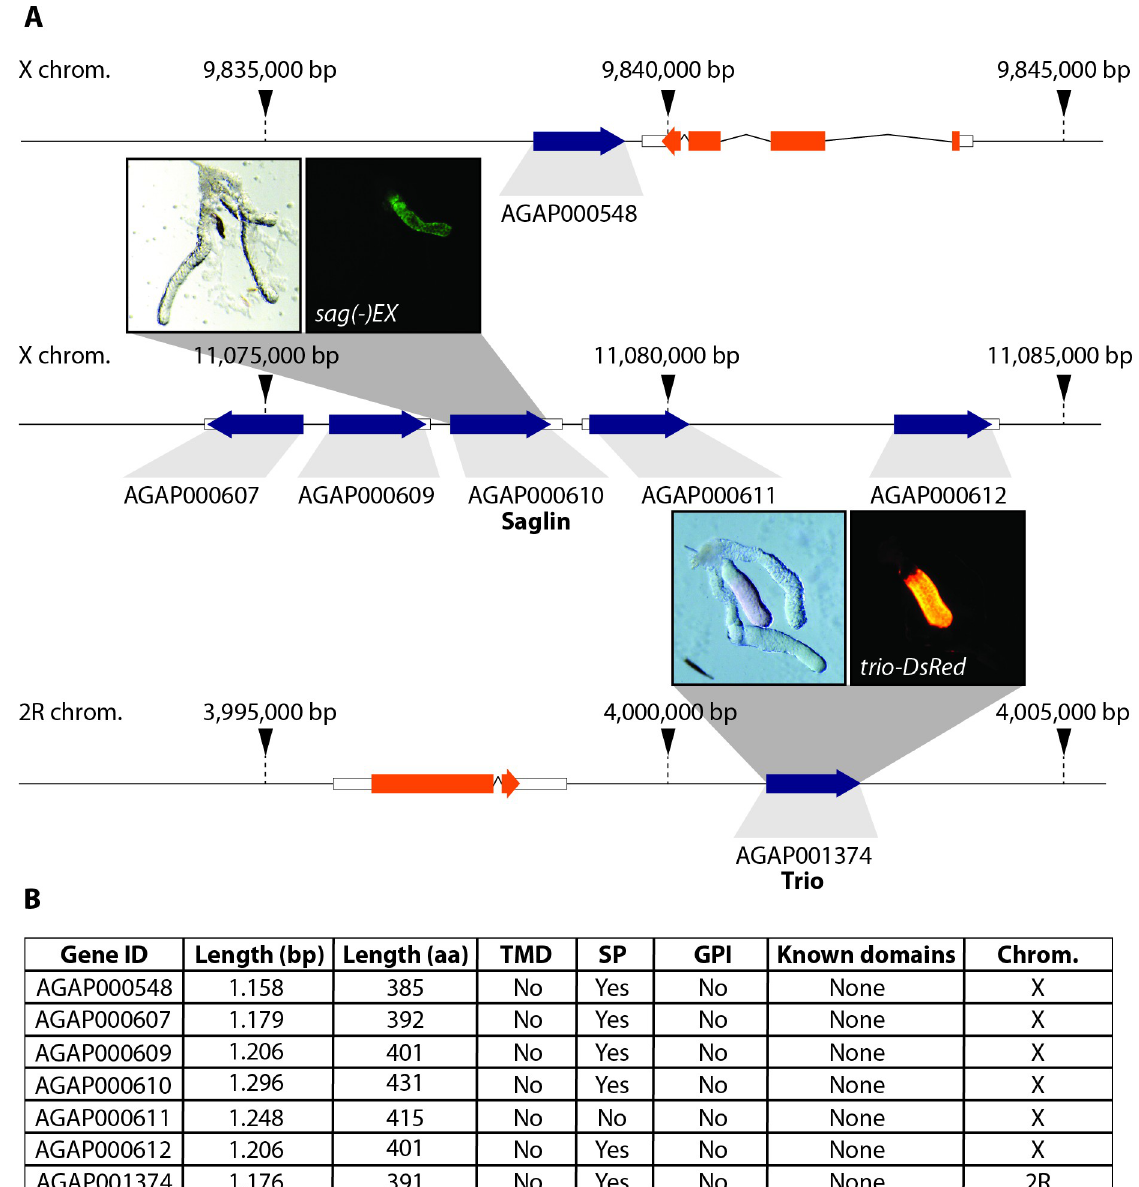
Fig 1. SG1 family proteins in the An . gambiae complex. A) Genomic organization of the SG1 family according to VectorBase (Release 54). Genes encoding SG1 proteins are shown in blue and unrelated genes in orange. Note the high proportion of X-linked genes and the absence of introns in the entire protein family. Representative images of salivary glands dissected from a sag(-)EX and a trio-DsRed female where EGFP and DsRed are expressed under the control of the saglin and trio promoters. Both promoters are active in the median lobe. B) Table summarizing different parameters and the presence of specific domains for all members of the SG1 family. Sequence information was retrieved from VectorBase (version 54) [30]. Signal peptide (SP) predictions were performed using SignalP 5.0 [31], transmembrane domains (TMD) were predicted with TMHMM 2.0 [53], GPI-anchors (GPI) with GPIpred [54] and other known domains with SMART